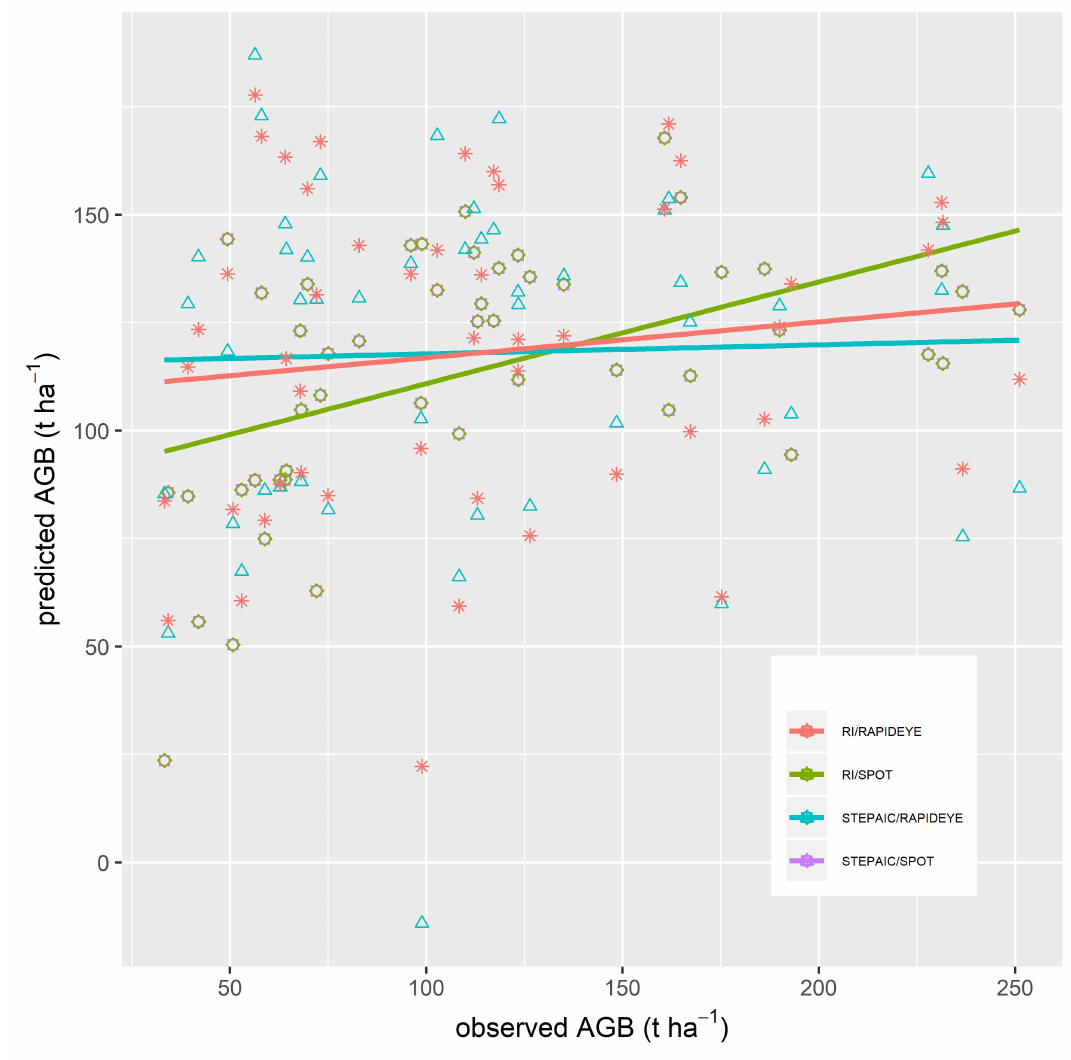
Figure 5. The observed AGB against the predicted AGB, determined by variable selection approaches and two satellite